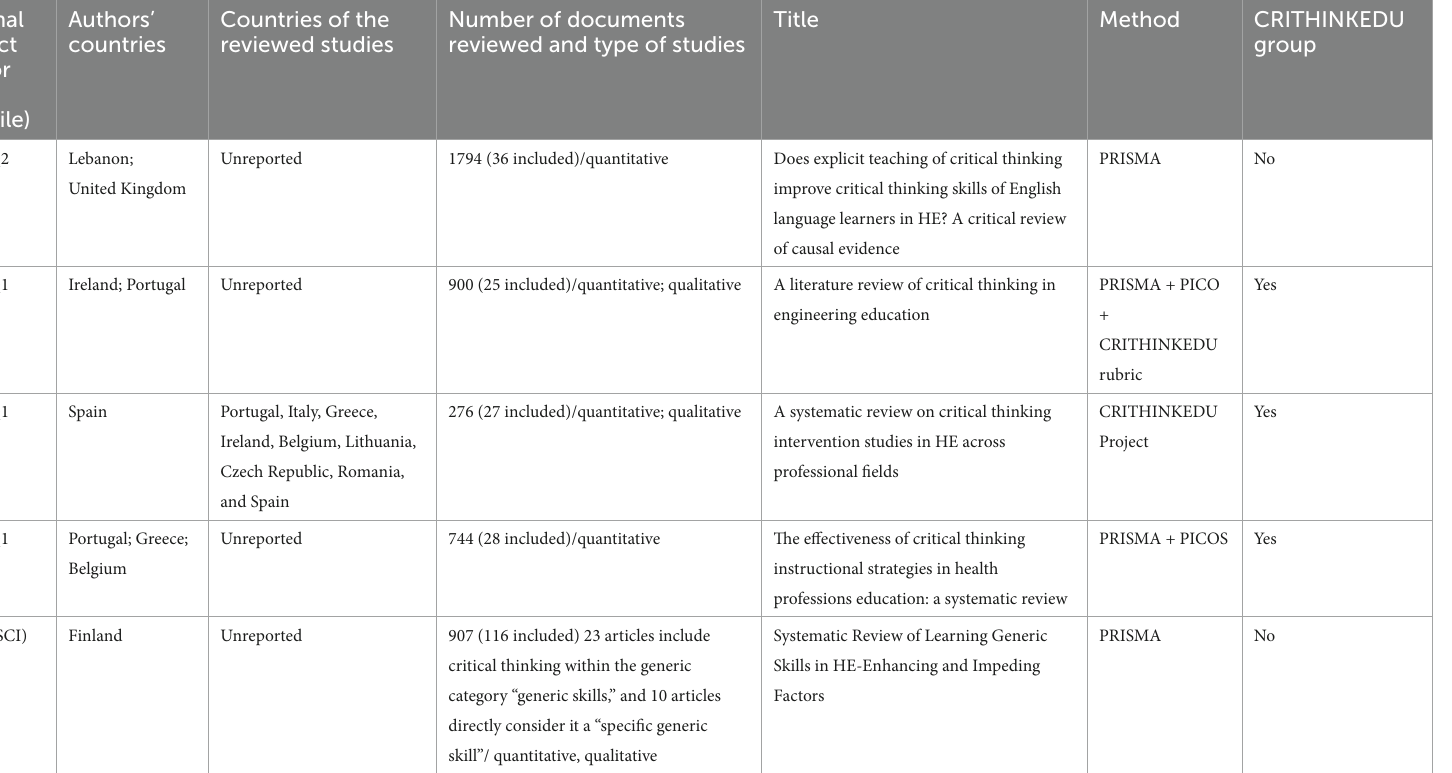
TABLE 3 Characteristics of the included